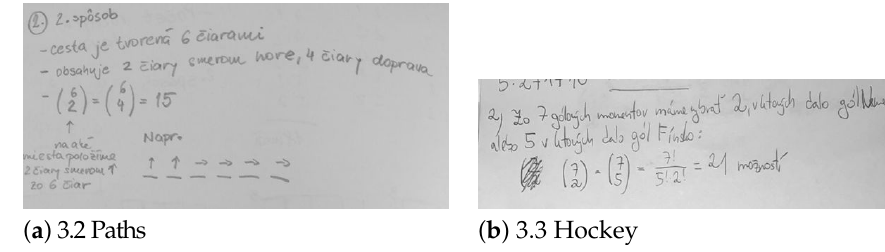
) in the solutions of ) = ( n n − k k